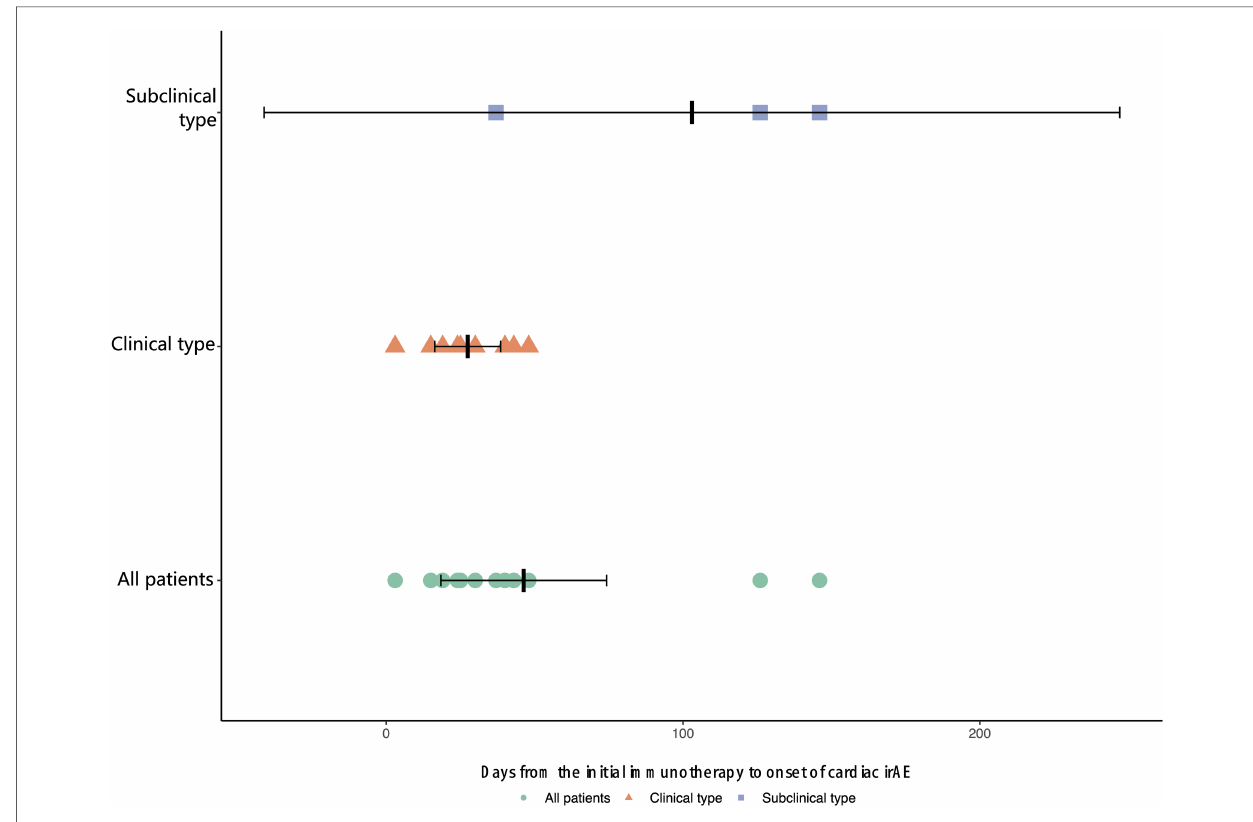
FIGURE 1 Time from the initial immunotherapy to onset of cardiac